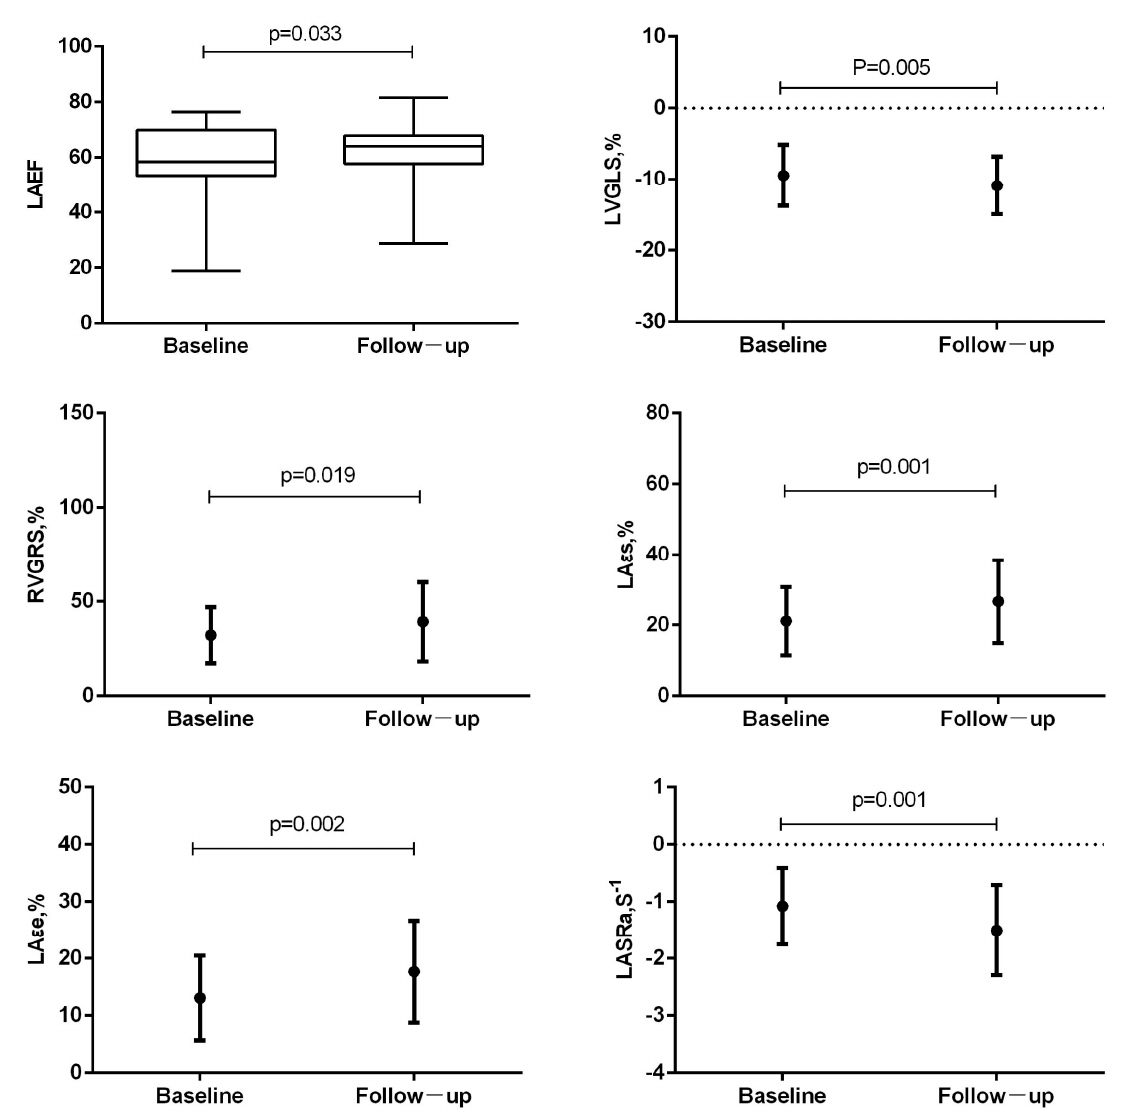
Figure 3. Differences in the left atrial and biventricular function and myocardial strain between baseline and follow-up period. LAEF was the only significantly recovered functional parameter. The absolute value of LVGLS, RVGRS, LA Ԑ s, Ԑ e, and SRa was significantly increased.